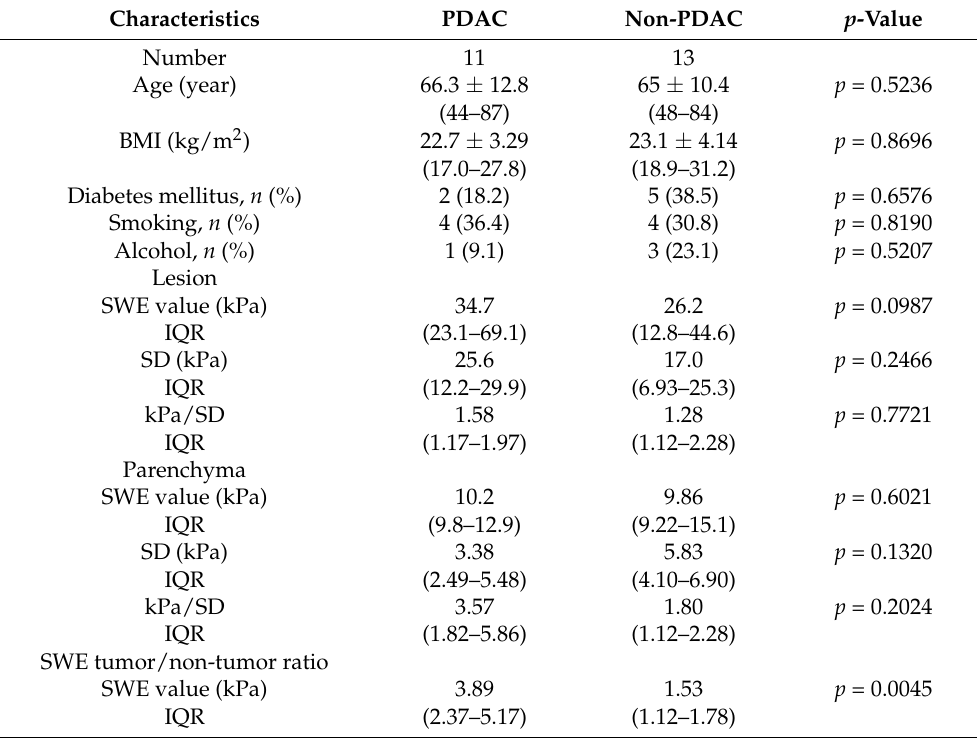
Table 3. Patients characteristics with mapping pattern